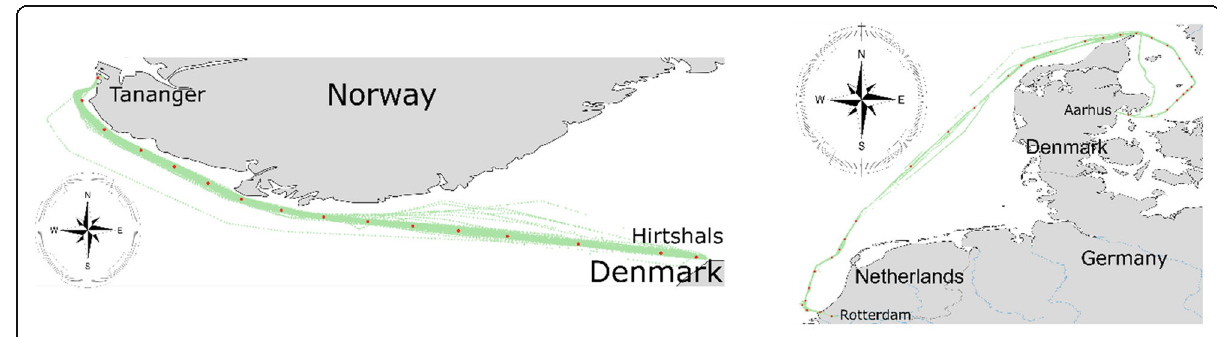
Fig. 2 Examples of the k-medians clustering algorithm used for extracting routes and obtaining waypoints. Green dots are AIS data samples and red dots the waypoints resulting from our